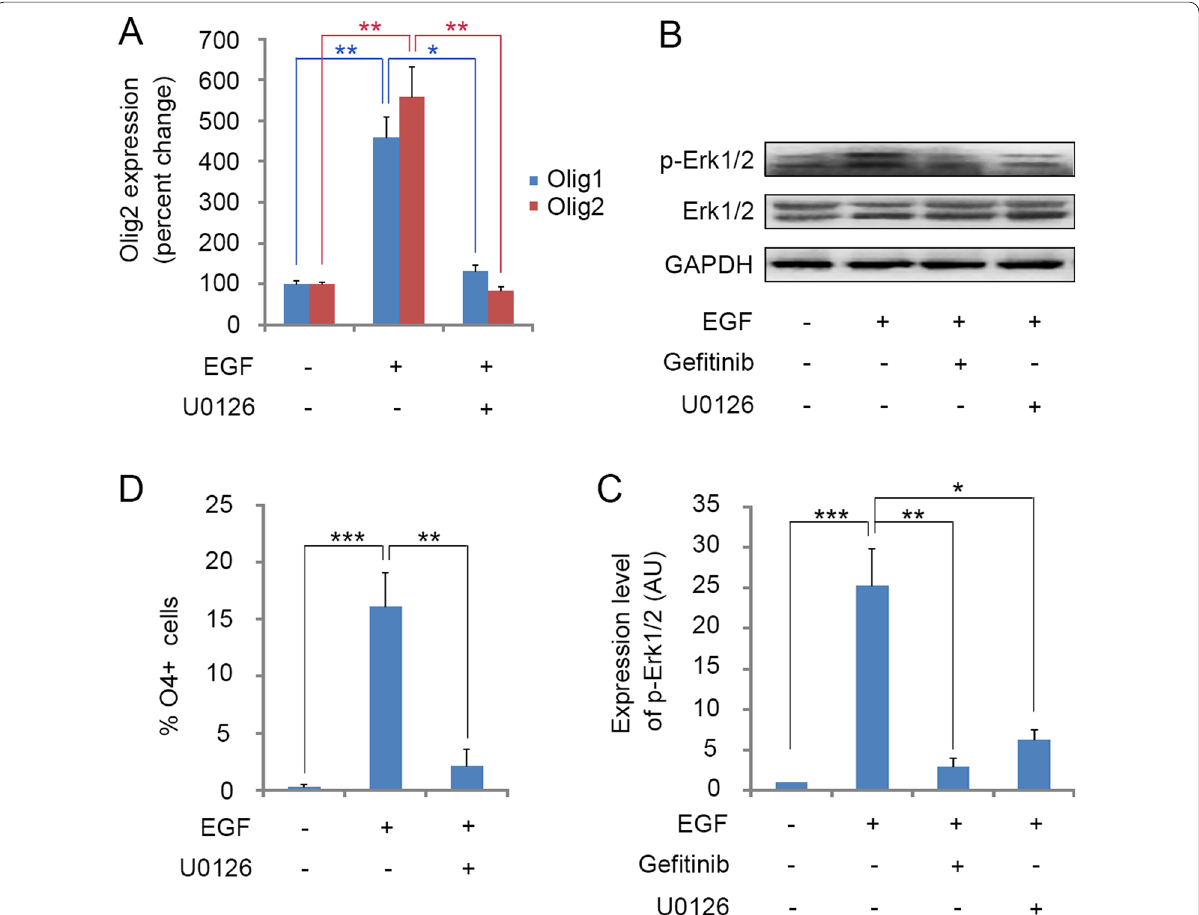
Fig. 4 EGF induces the expression of oligodendrogenic genes through Erk pathway during Sox10-based reprogramming. A Gene expression of Olig1 and Olig2 after 36 h of EGF and EGF U0126 treatment. B Western blotting analysis of p-Erk1/2 and Erk1/2 after 2 h of EGF, EGF + and EGF U0126 treatment. C Quantitative analysis of p-Erk1/2 and Erk1/2 protein expression in cultures presented in B . Histograms express results + in arbitrary units, using Ctrl cell values as 100%. D Quantification of the percentage of O4 + cells in reprogramming cultures treated with EGF or EGF U0126. Statistical analyses are presented as Mean SD, n 3. *P < 0.05, **P < 0.01, ***P < + ± =